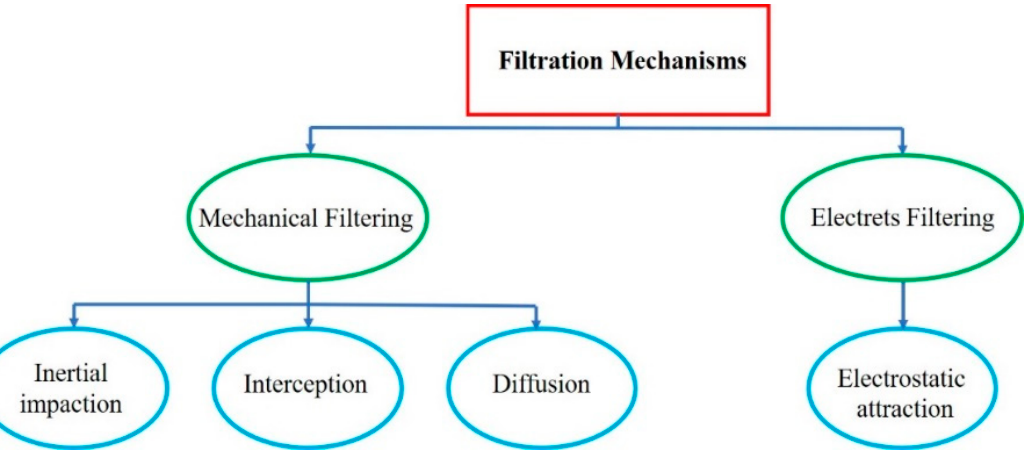
Figure 11. Different mechanisms in the filtration process [1].